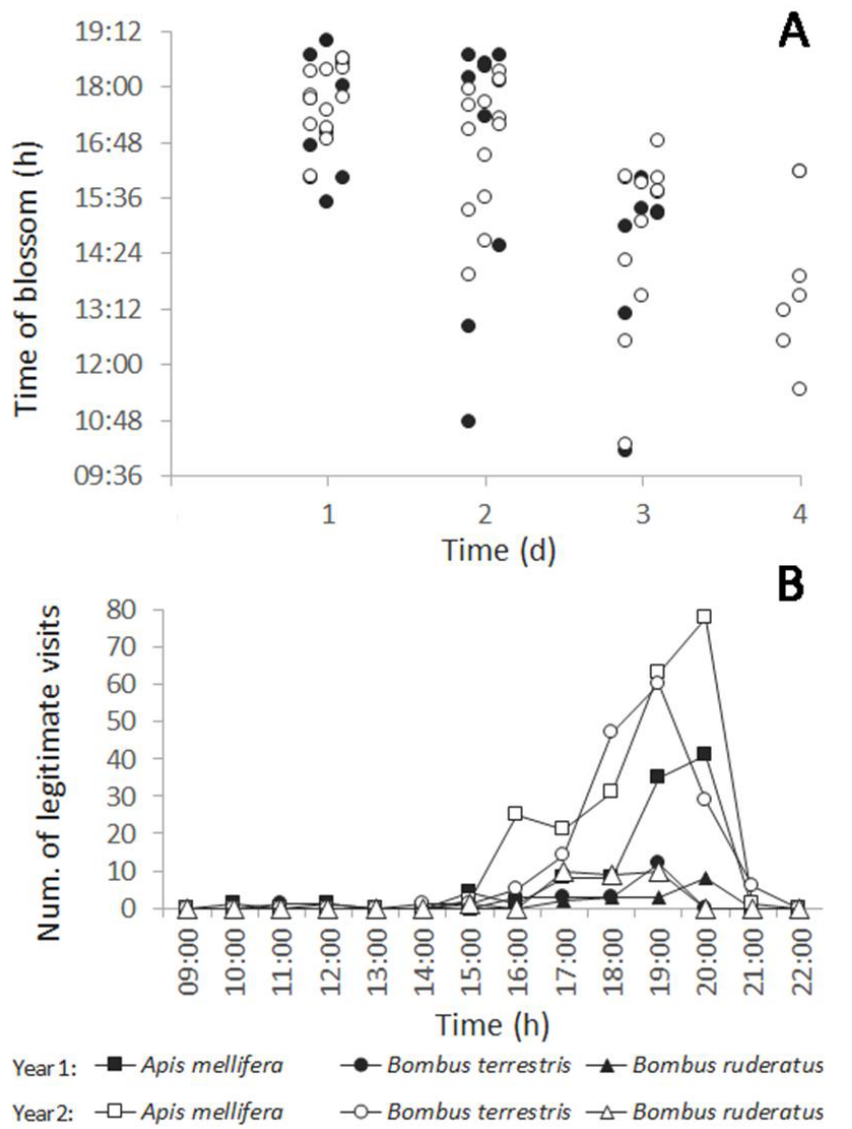
Figure 1. (A) Time of the day when flowers opened during the flower life for each study year. Black circles for year one; white for year two. (B) The number of legitimate visits for the main pollinator species of Vicia faba , for each hour and all flowers studied in both